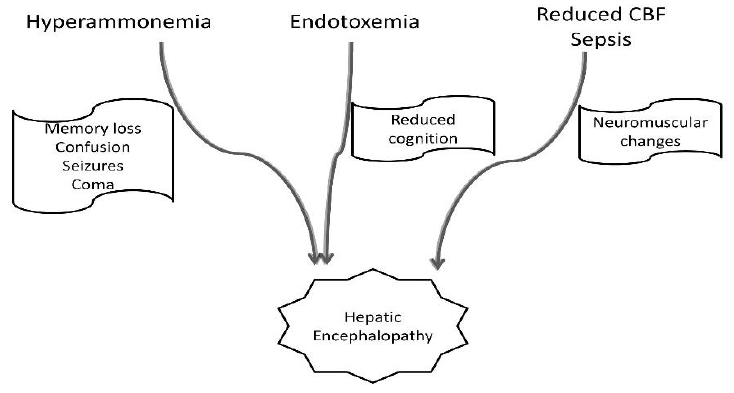
Figure 2. The mechanisms of hepatic encephalopathy in cirrhotic patients.